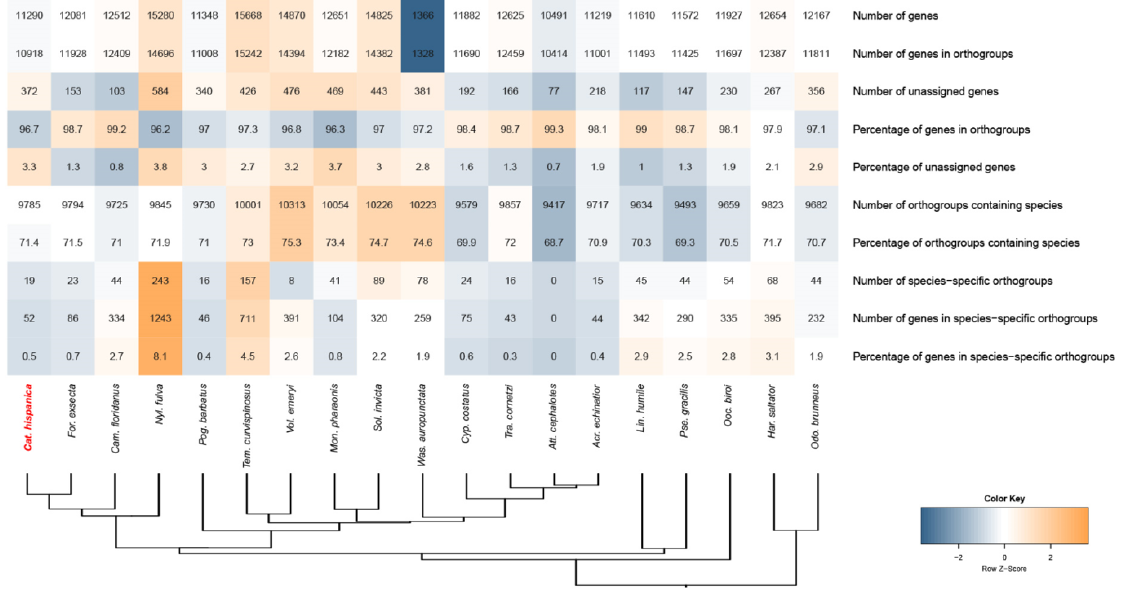
Figure 4: Summary values from the ortholog analyses. The color intensity indicates the z-score of variation (deviation from the mean) among all species, from the smallest value (blue) to the highest value (orange). Species are ordered according to their phylogenetic positions inferred from a concatenated alignment of single-copy